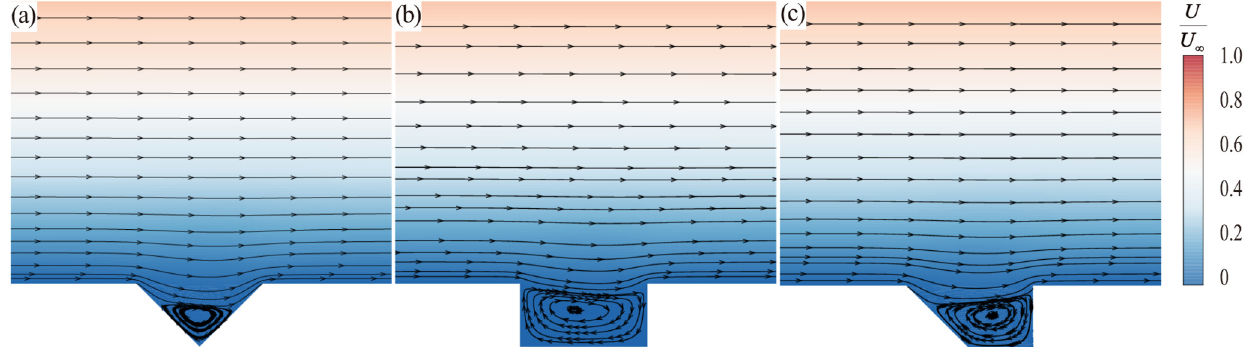
Figure 8. The streamline distribution near the groove where the map was colored by the dimensionless velocity / U U ∞ : ( a – c ) the three types of grooves of triangle, rectangle, and trapezoid, respectively.